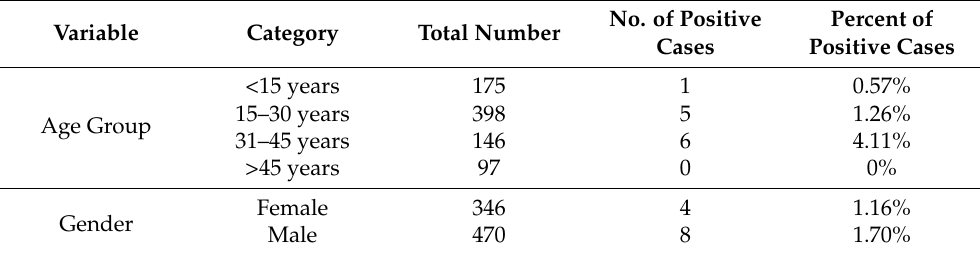
Table 4. Positive malaria cases detected by PCR method according to gender and age group in an asymptomatic malaria study.